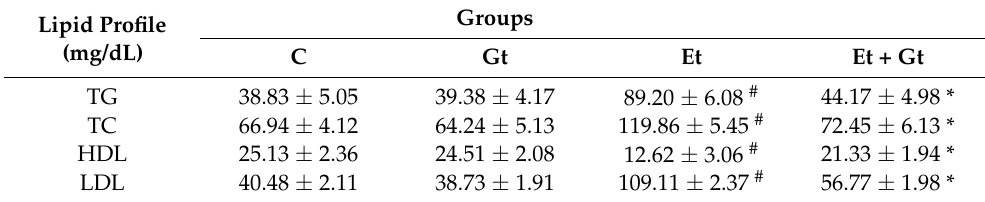
Table 1. Alcohol-induced dyslipidemia reversed by 6-gingerol. Data were expressed as mean ± SD (N = 6). # p < 0.005 compared with control * p < 0.05 compared with ethanol groups. Values were shown in control (C), 6-gingerol (Gt)-, ethanol (Et)- and ethanol plus 6-gingerol (Et + Gt)- treated